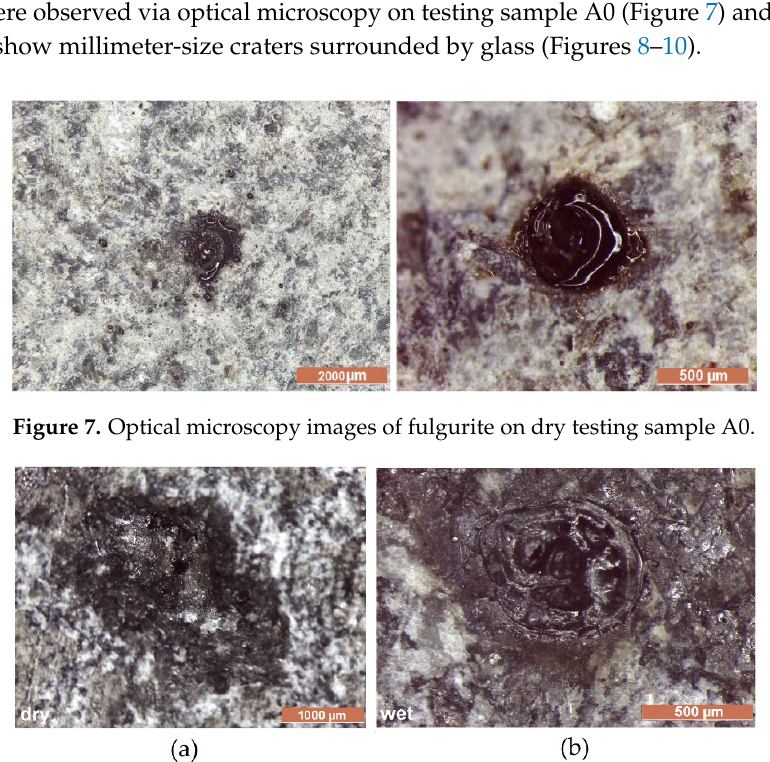
Figure 8. Optical microscopy images of fulgurite on dry sample A1 ( a ) and wet sample A3 ( b ).